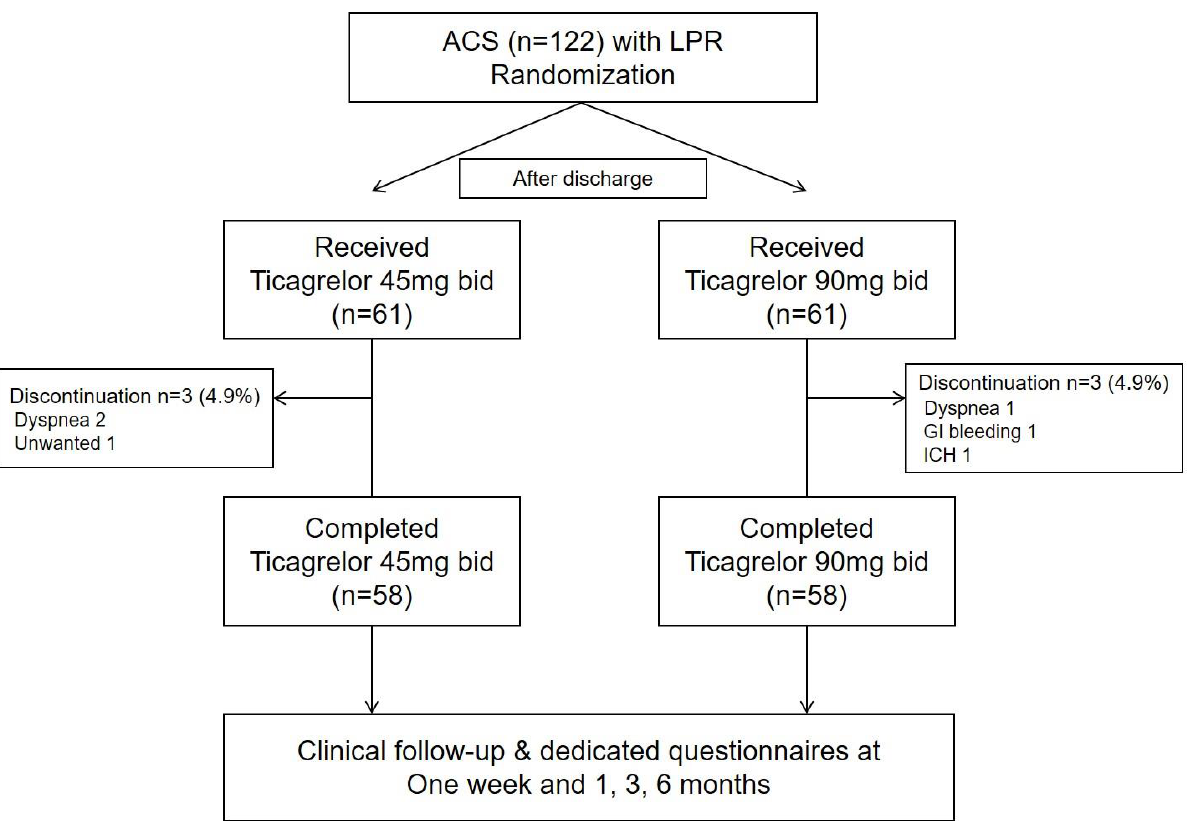
Figure 1. Study flow. ACS = acute coronary syndrome; GI = gastrointestinal; ICH = intracranial hemorrhage; LPR = low platelet reactivity (defined by P2Y 12 reaction unit <85).